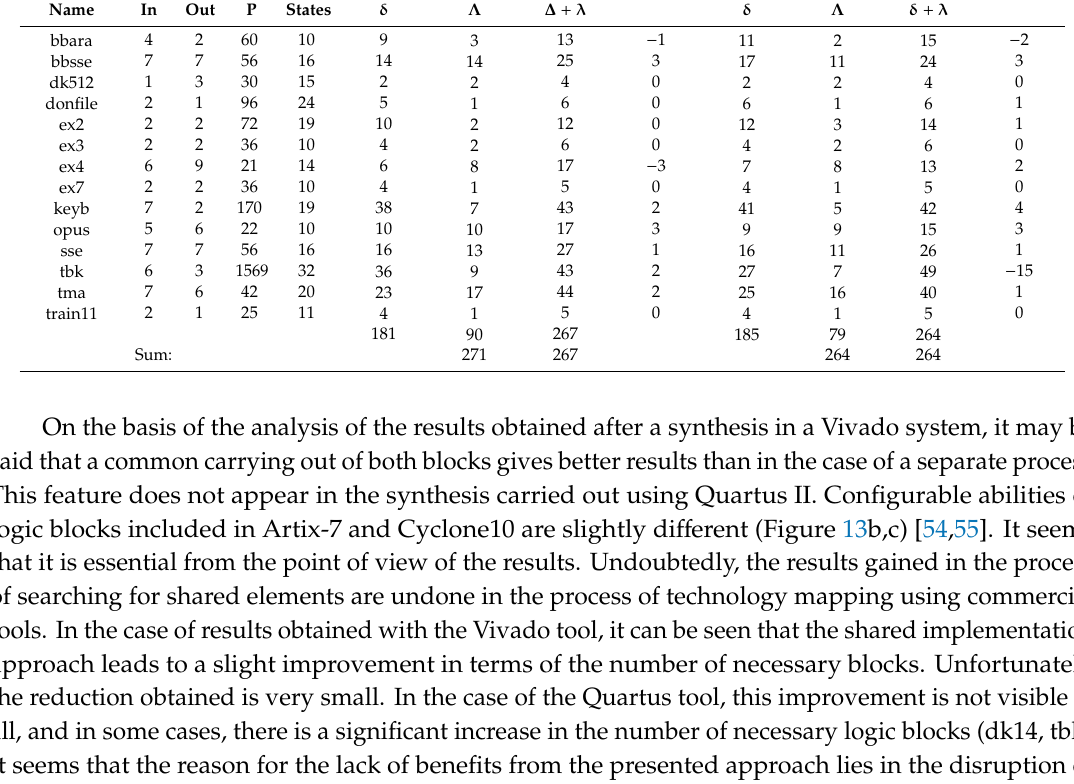
Vivado (Artix 7) Quartus(Cyclone 10) Separate Shared Separate Shared sep.-sha. implem. implem. implem. implem.